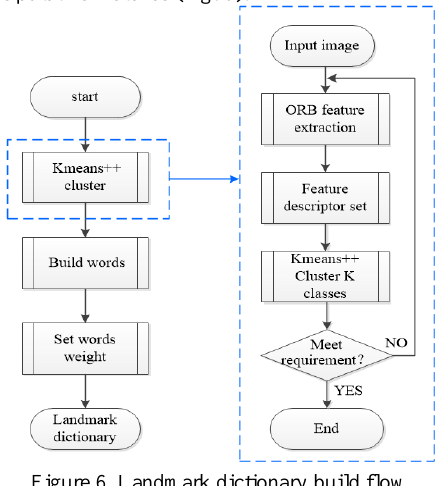
Figure 6. Landmark dictionary build flow